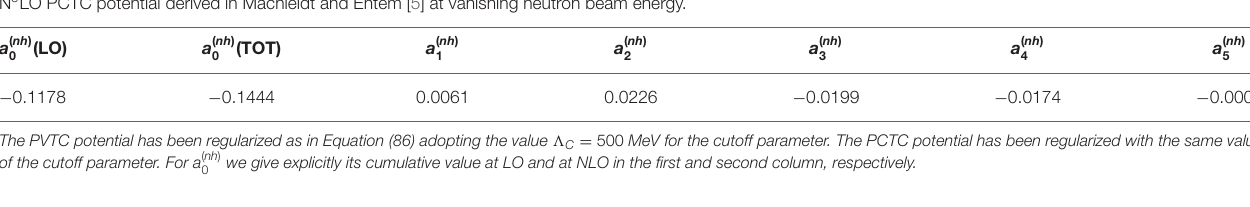
n - p spin rotation in units of Rad m − 1 calculated for the χ EFT N 2 LO PVTC potential described in E